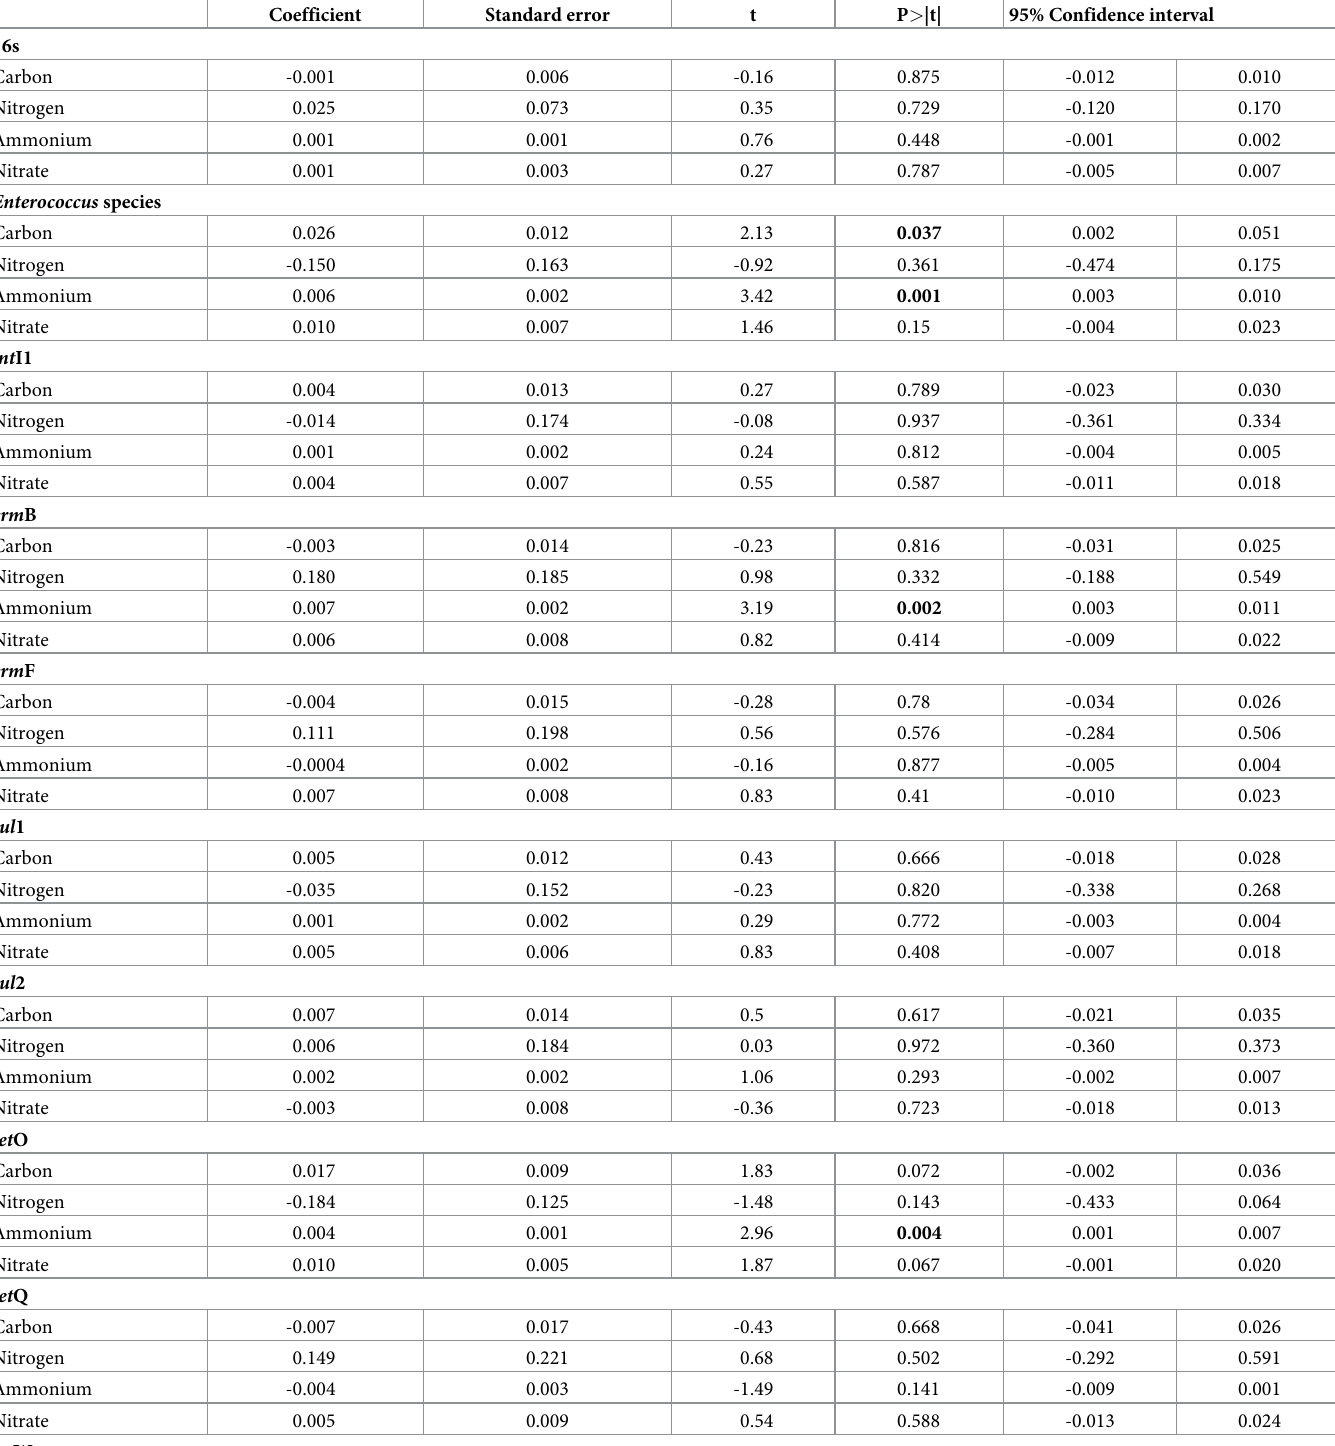
Table 3. Effect of soil chemical measurements on the concentration of bacteria and antibiotic resistance genes in beef cattle backgrounding operation. Results are adjusted for sampling periods and areas (feeding and grazing areas) within the backgrounding